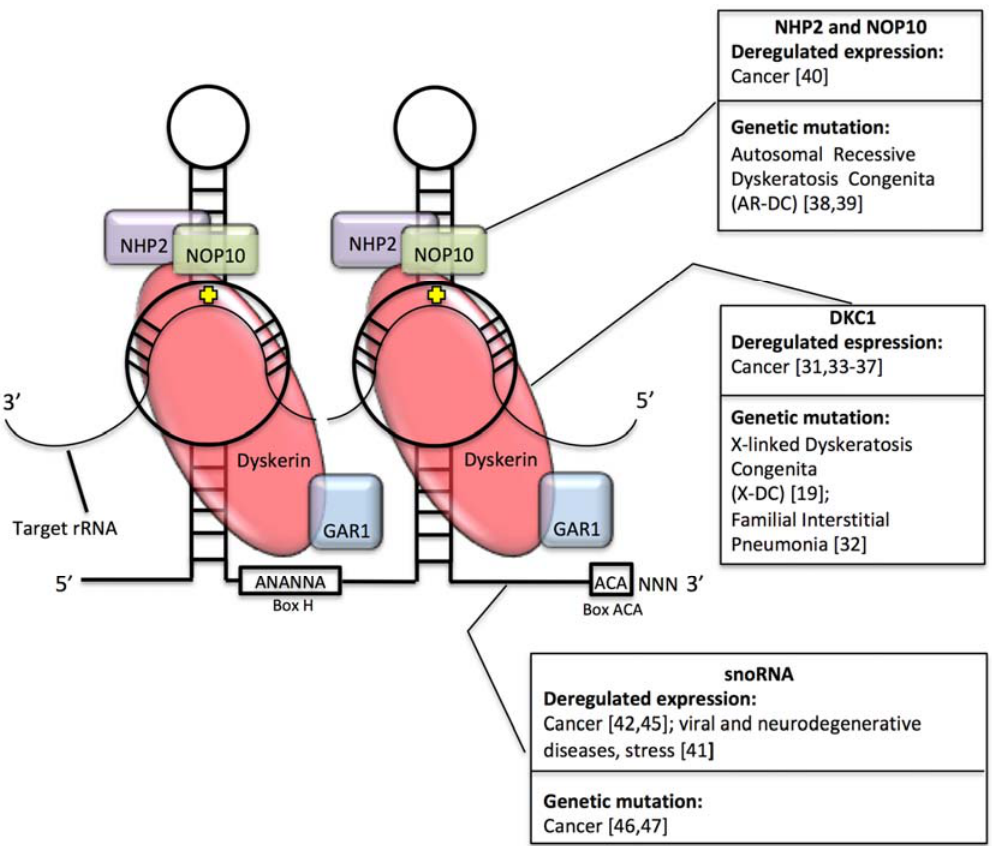
Figure 2. Schematic representation of the Box H/ACA riboucleoprotein (RNP) pseudouridylation complex, with particular reference to the diseases associated to alterations in the expression of each component.